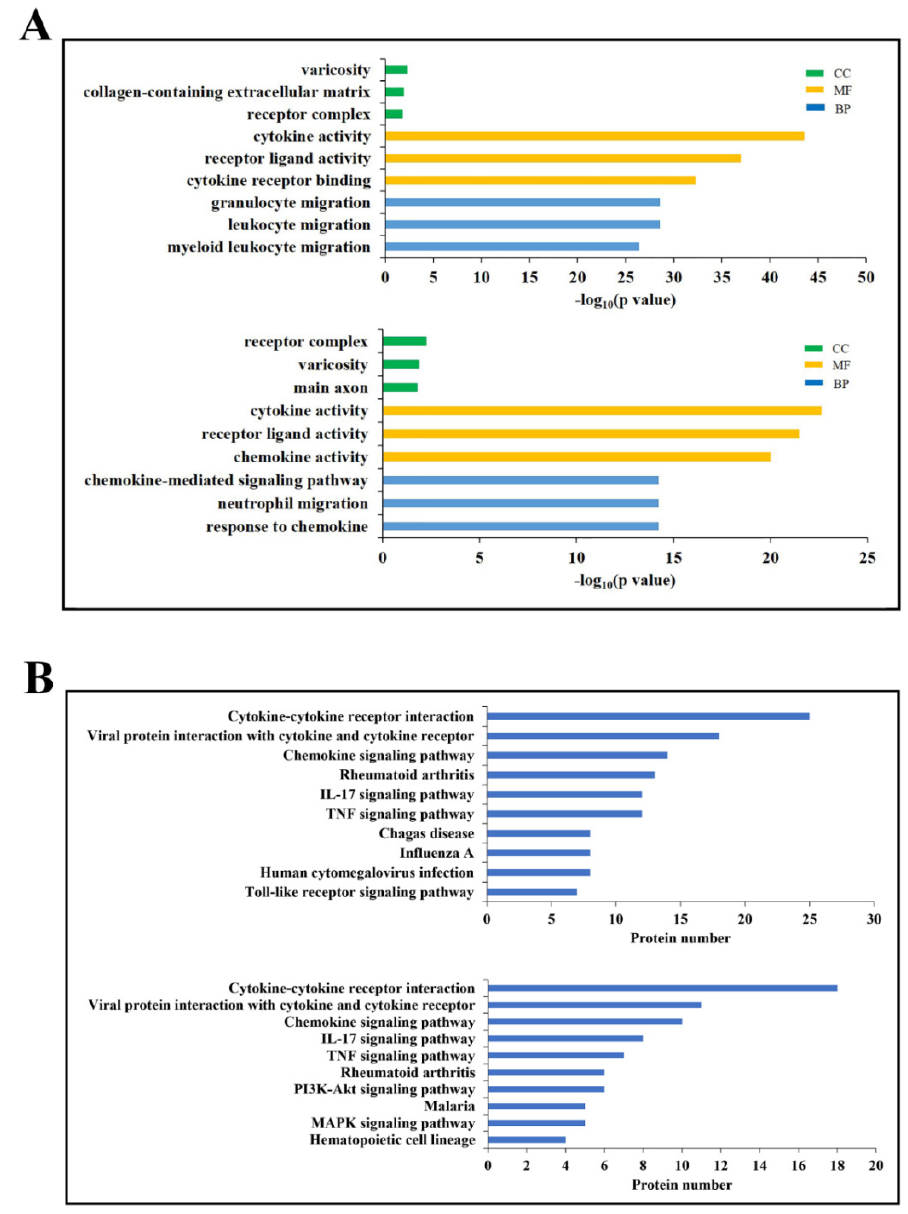
Figure 2. GO and KEGG enrichment of differentially expressed cytokines (DECs). ( A ) DECs of the top three significantly enriched GO terms at 6 (upper) and 24 (lower) hours post-infection (hpi). CC: Cellular Component, MF: Molecular Function, BP: Biological Process. ( B ) DECs of the top 10 significantly enriched KEGG pathways at 6 (upper) and 24 (lower) hpi.